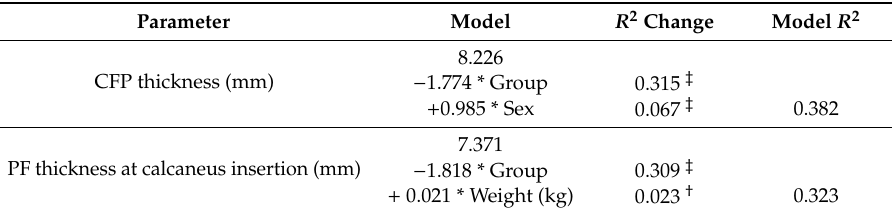
Table 3. Multivariate predictive analysis for CFP and PF thicknesses for patients with Achilles tendinopathy and controls.